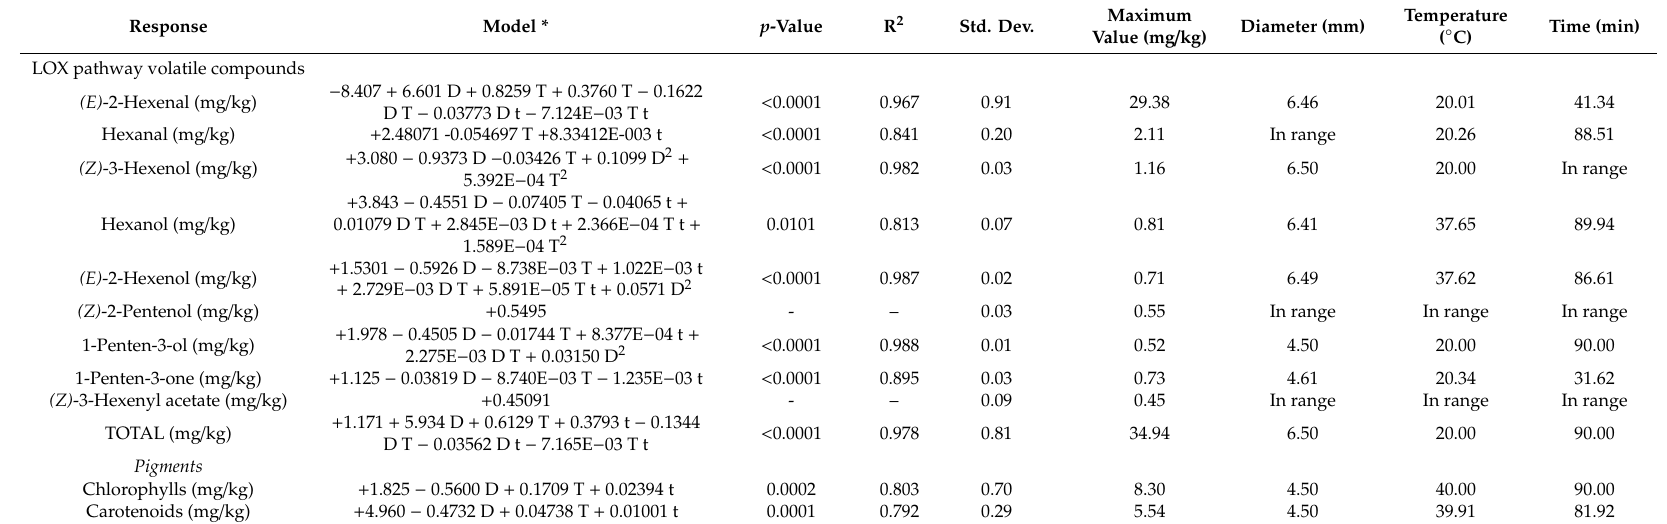
Table 3. Proposed models in terms of actual factors with statistical parameters (analysis of variance (ANOVA) for the fit of experimental data was used) and optimal values of the technological factors for the response maximum values. Irrigated Arbequina cultivar sample (MI =